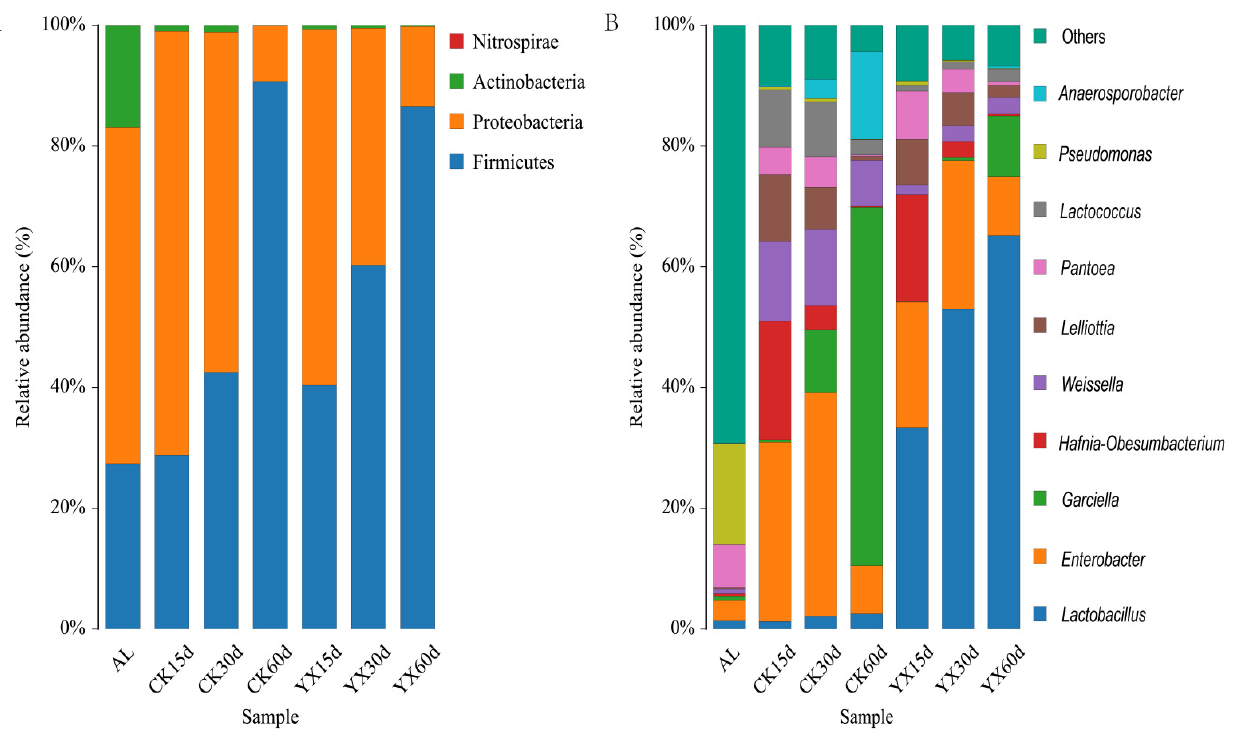
Figure 5. Bar plots of bacterial community and relative abundances by phylum ( A ) and genus ( B ) in alfalfa silage. AL, alfalfa material before ensiling; CK, control; YX, inoculated with commercial LAB YX; the numbers following CK and YX stand for ensiled days of silage.